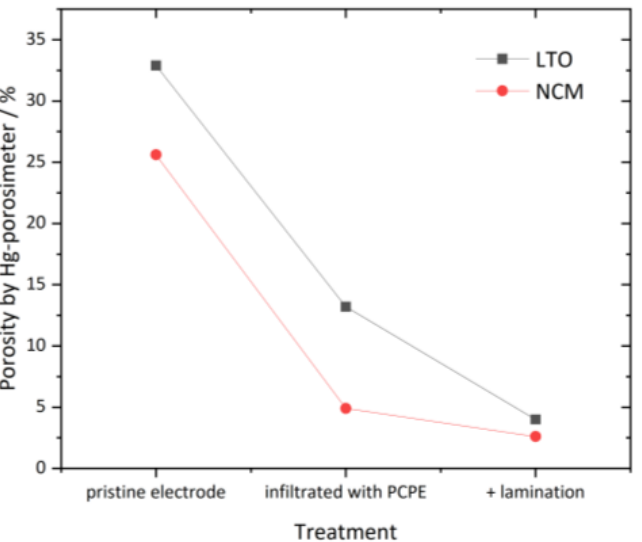
Figure 5. Calculated porosity values of LTO and NCM electrodes measured by Hg-porosimetry to determine grade of polymer intrusion; calculation method is described in the supplementary